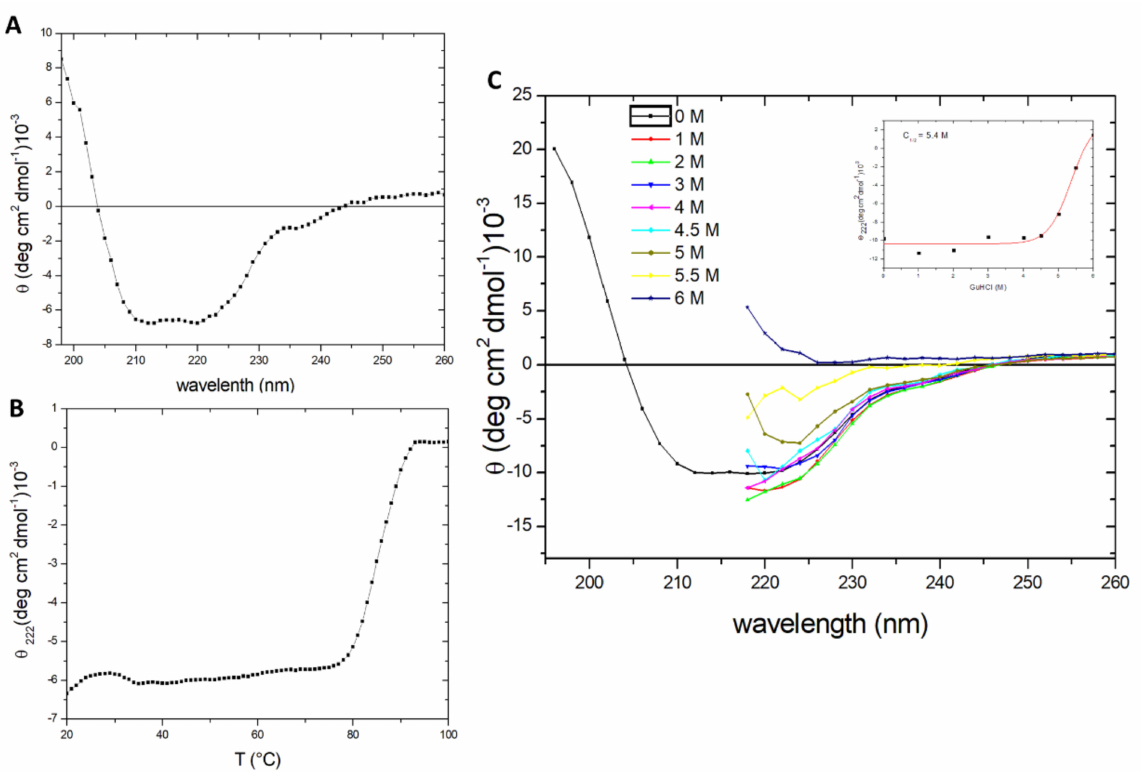
Figure 2. Thermal and chemical stability of DtCel5A by CD spectroscopy. ( A ) Far-UV CD spectra in 20 mM sodium phosphate buffer (pH 7.4); ( B ) Temperature-induced unfolding transitions at pH 7.4; ( C ) Chemical unfolding transition of DtCel5A in the presence of increasing concentrations of GuHCl. The inset of panel C shows the chemically induced unfolding as a function of GuHCl